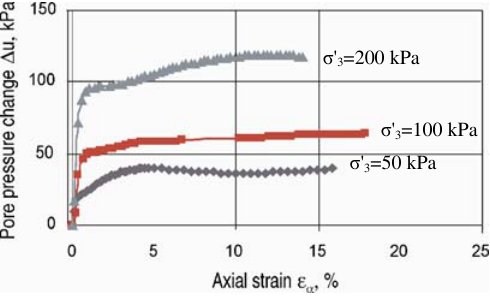
Fig 10 . Pore pressure change against strain of CU triaxial compression test